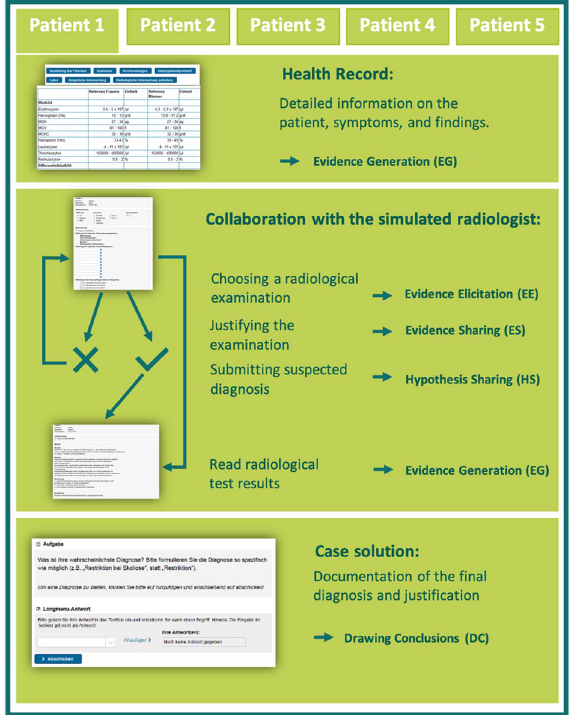
Fig. 1 Overview of the Structure of the Simulation With Corresponding Assignment of Activities to the